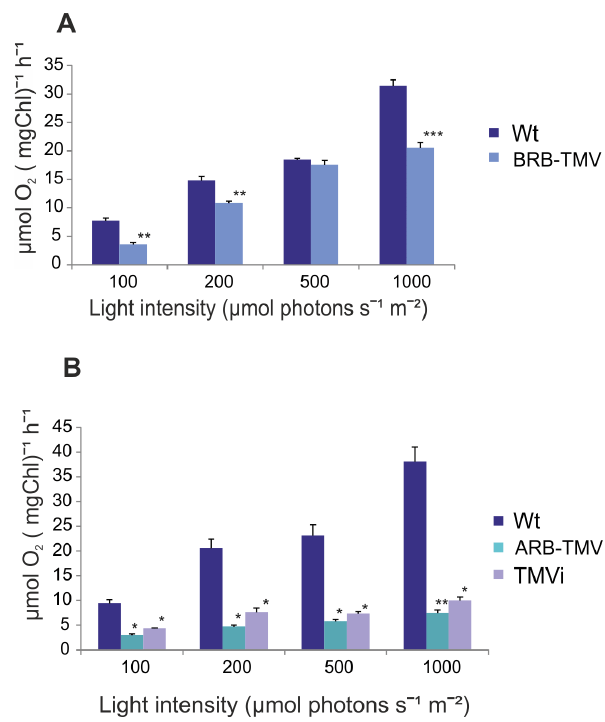
Figure 5. Light-responsive O 2 -evolution of photosystem II of the different test plants, as compared to the wild type control plants. BRB- (A), and ARB-TMV transgenic and TMVi plants (B). O 2 - evolution was measured of freshly isolated thylakoid membranes using DCBQ as an electron acceptor. Four light intensities is shown in x-axis ( m mol photons s 2 1 m 2 2 ) and the O 2 -evolution in y-axis ( m mol O 2 (mgChl) 2 1 h 2 1 ). Standard error of mean is presented as bars above the columns (n=4, consisting of five biological replicates). The confidence level determined by the Student’s T-test, with confidence level higher than 95% is indicated by *, higher than 99% indicated by **, and higher than 99,9% indicated by ***.